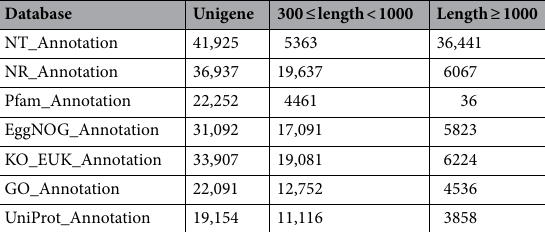
Table 1. Statistics of annotation analysis of unigenes.